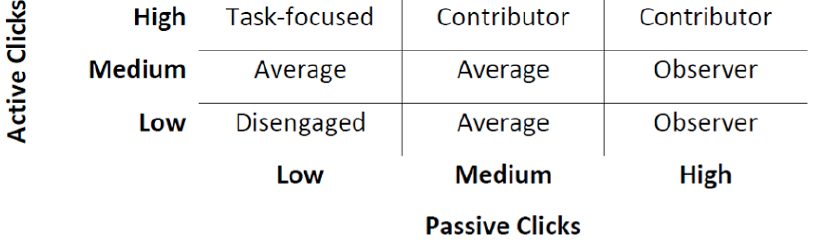
Table 2 matches data sources and the sample for each